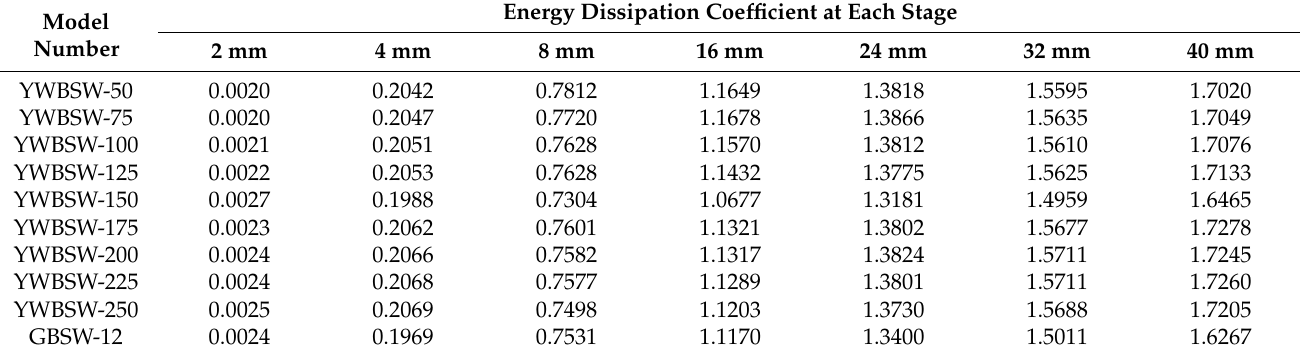
Table 11. Energy dissipation coefficients of models with different lap lengths.